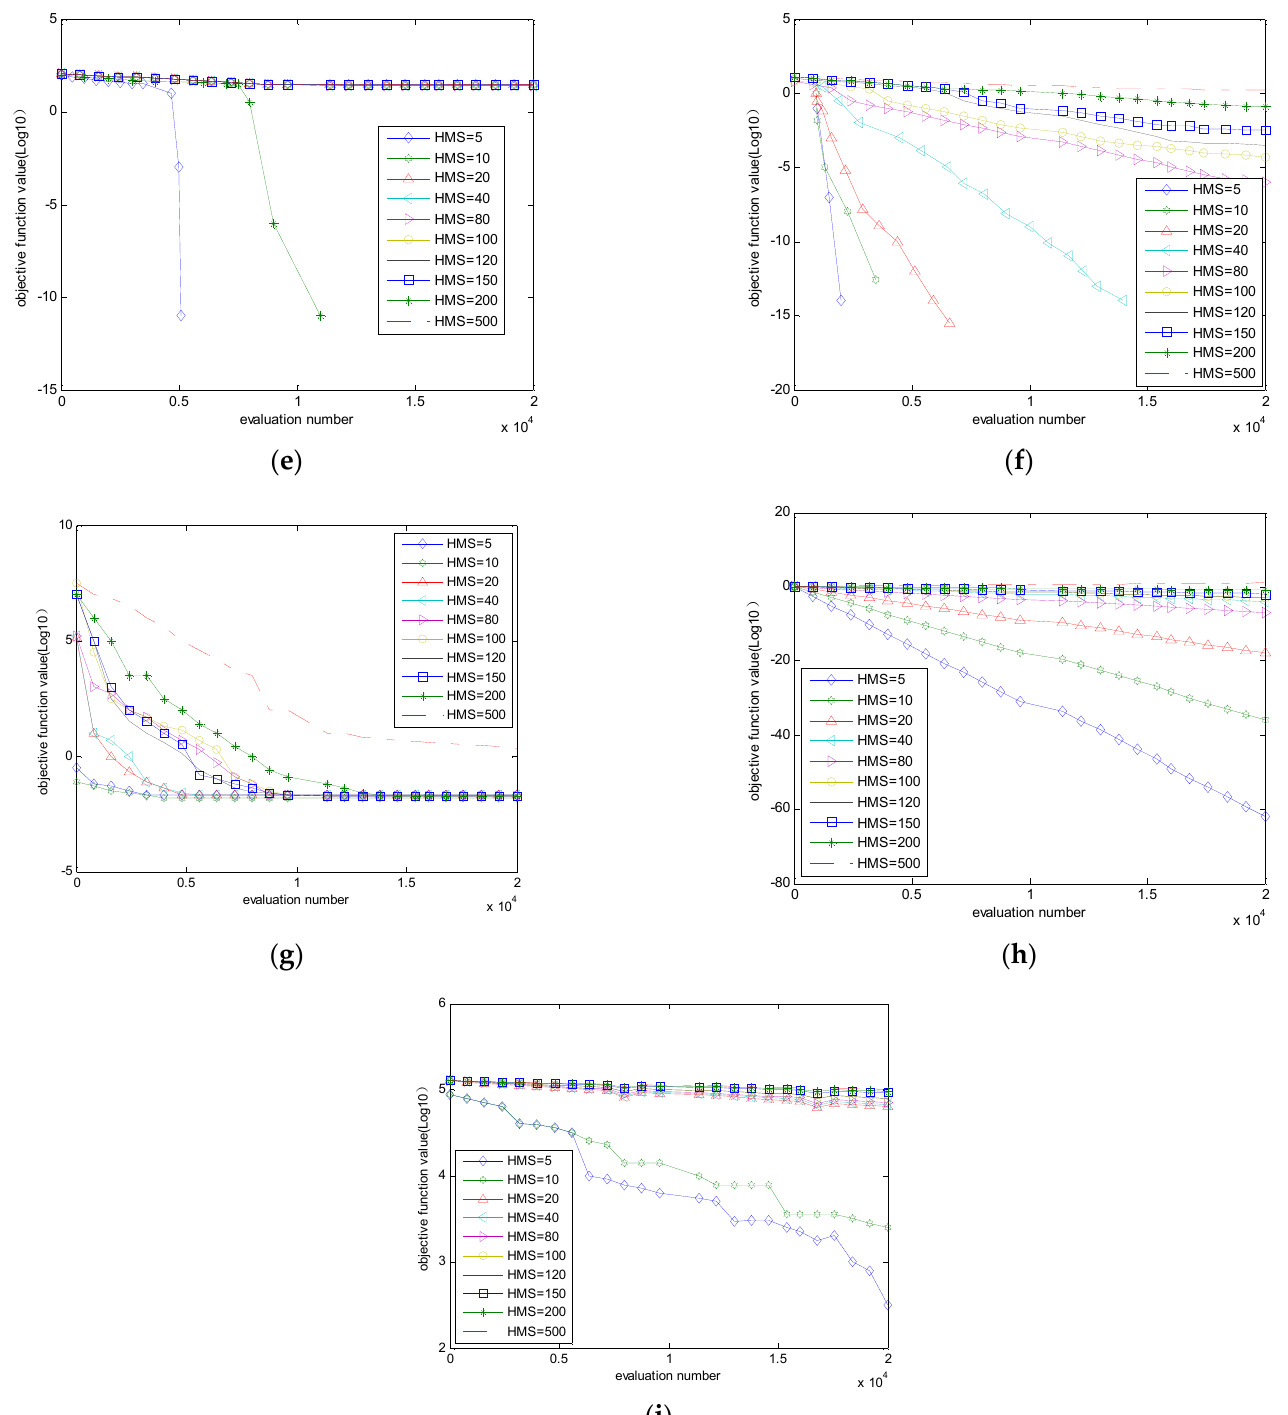
Figure 5. The optimization curve for different values of the parameter HMS: ( a ) f 1 ; ( b ) f 2 ; ( c ) f 3